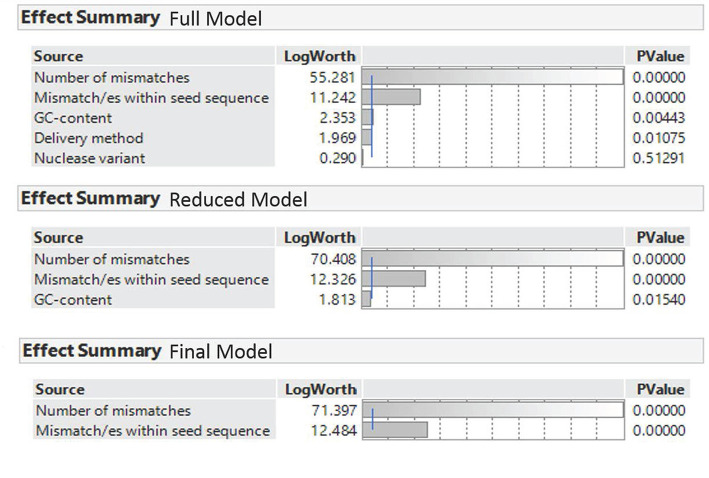
Effect summary of the binary regression analysis for the full model, the reduced model, and the final model. The LogWorth transformation adjusts P-value to provide an appropriate scale for graphing. A value that exceeds 2 is significant.